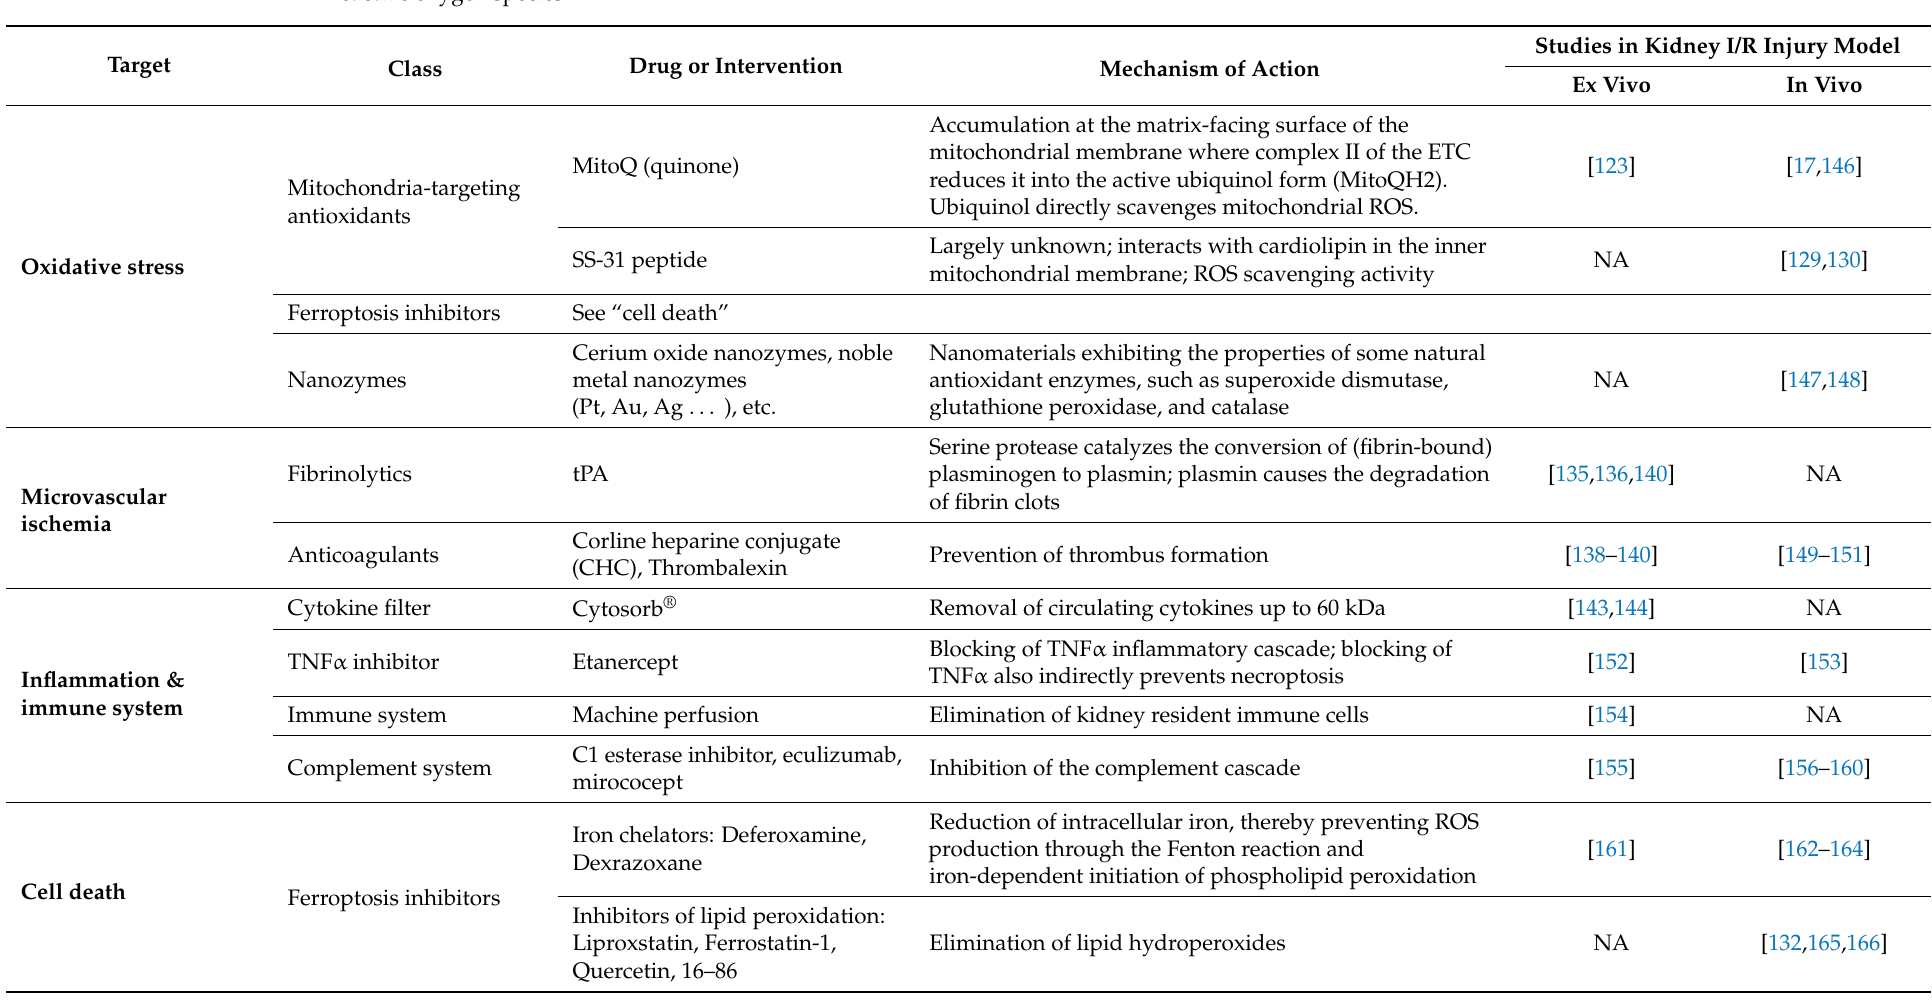
Table 1. Therapies for kidney ischemia–reperfusion (I/R) injury including examples of available studies. ETC, electron transport chain; NA, not available; ROS, reactive oxygen